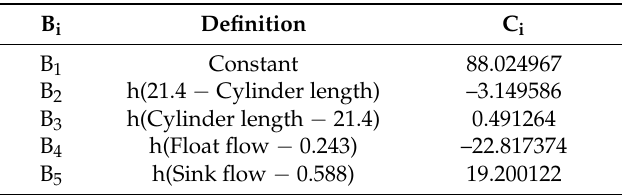
Table 2. List of basis functions of MARS model number one and their coefficients for feed into the vortex.